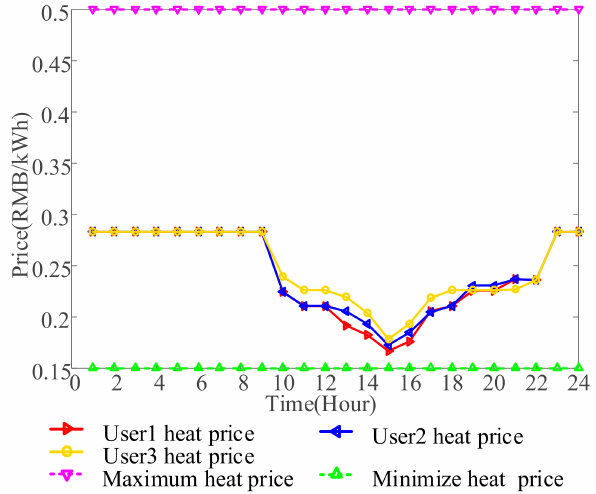
Figure 5. Heat trading prices after